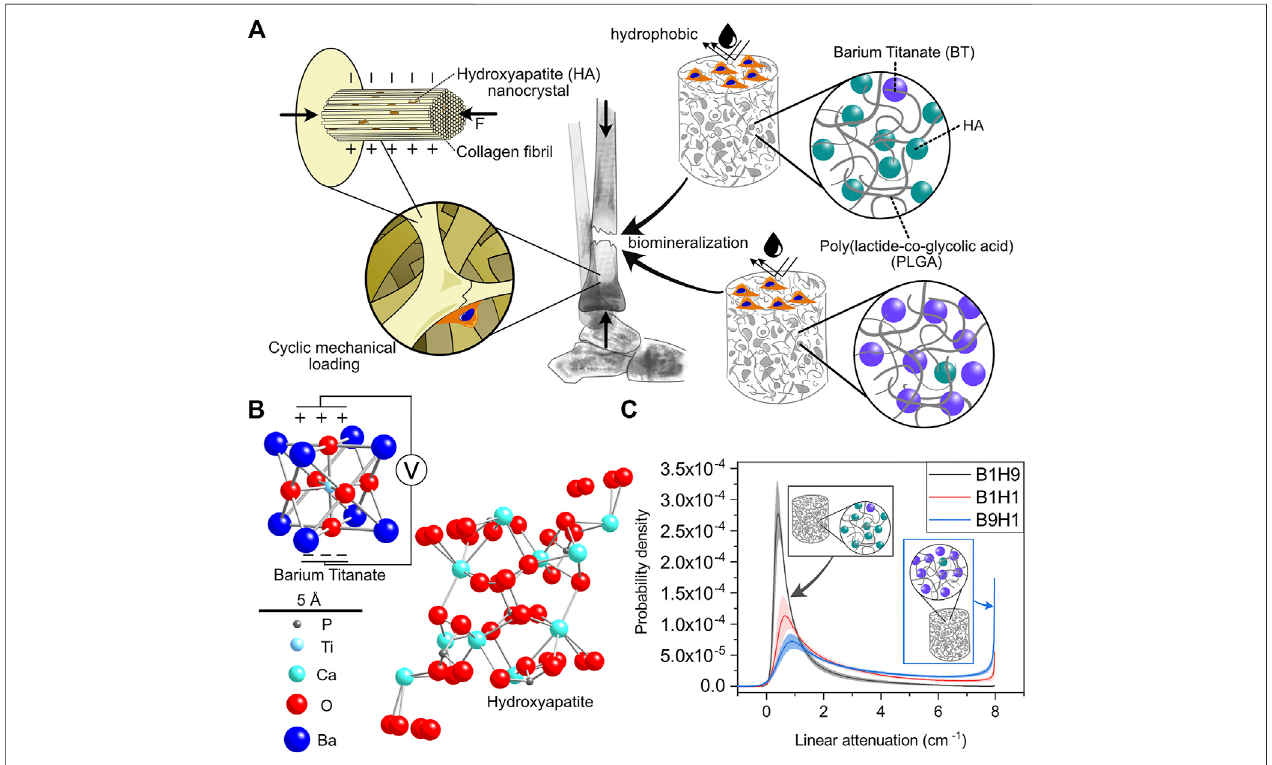
FIGURE 1 | Challenges in nanocomposite development for bone scaffolds. (A) Schematic illustration of the natural nanocomposite bone and nanocomposite scaffolds for bone tissue engineering with various barium titanate and hydroxyapatite compositions. (B) Unit cells of barium titanate and hydroxyapatite. (C) Histograms of linear attenuation coef fi cients obtained from high-resolution micro-CT of scaffolds containing barium titanate and hydroxyapatite in a volume ratio of 1:9 (B1H9), 1:1 (B1H1), or 9:1 (B9H1). The line represents the mean and the shaded area the s.d.